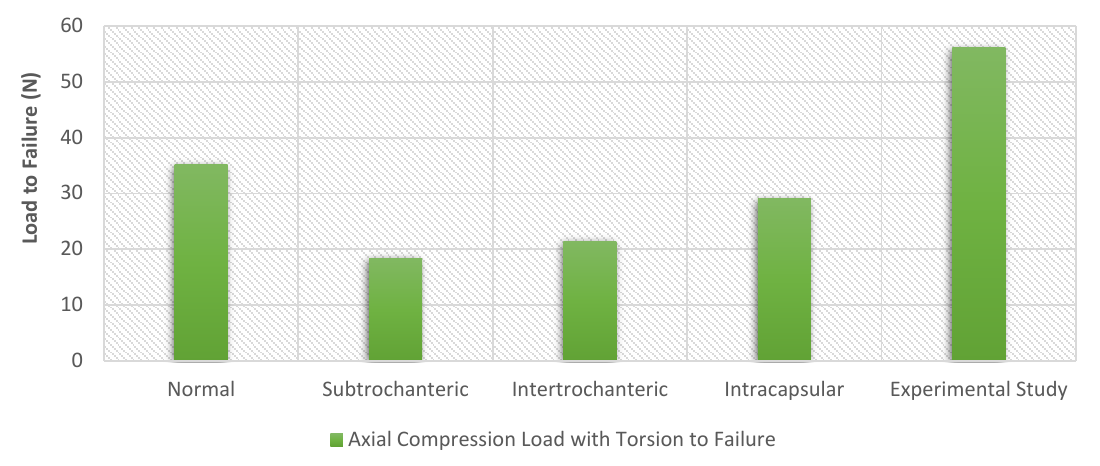
Figure 16. Load to failure for the experimental work performed by Hamandi et al [34] versus the computational finite element simulations results under the torsion scenario.